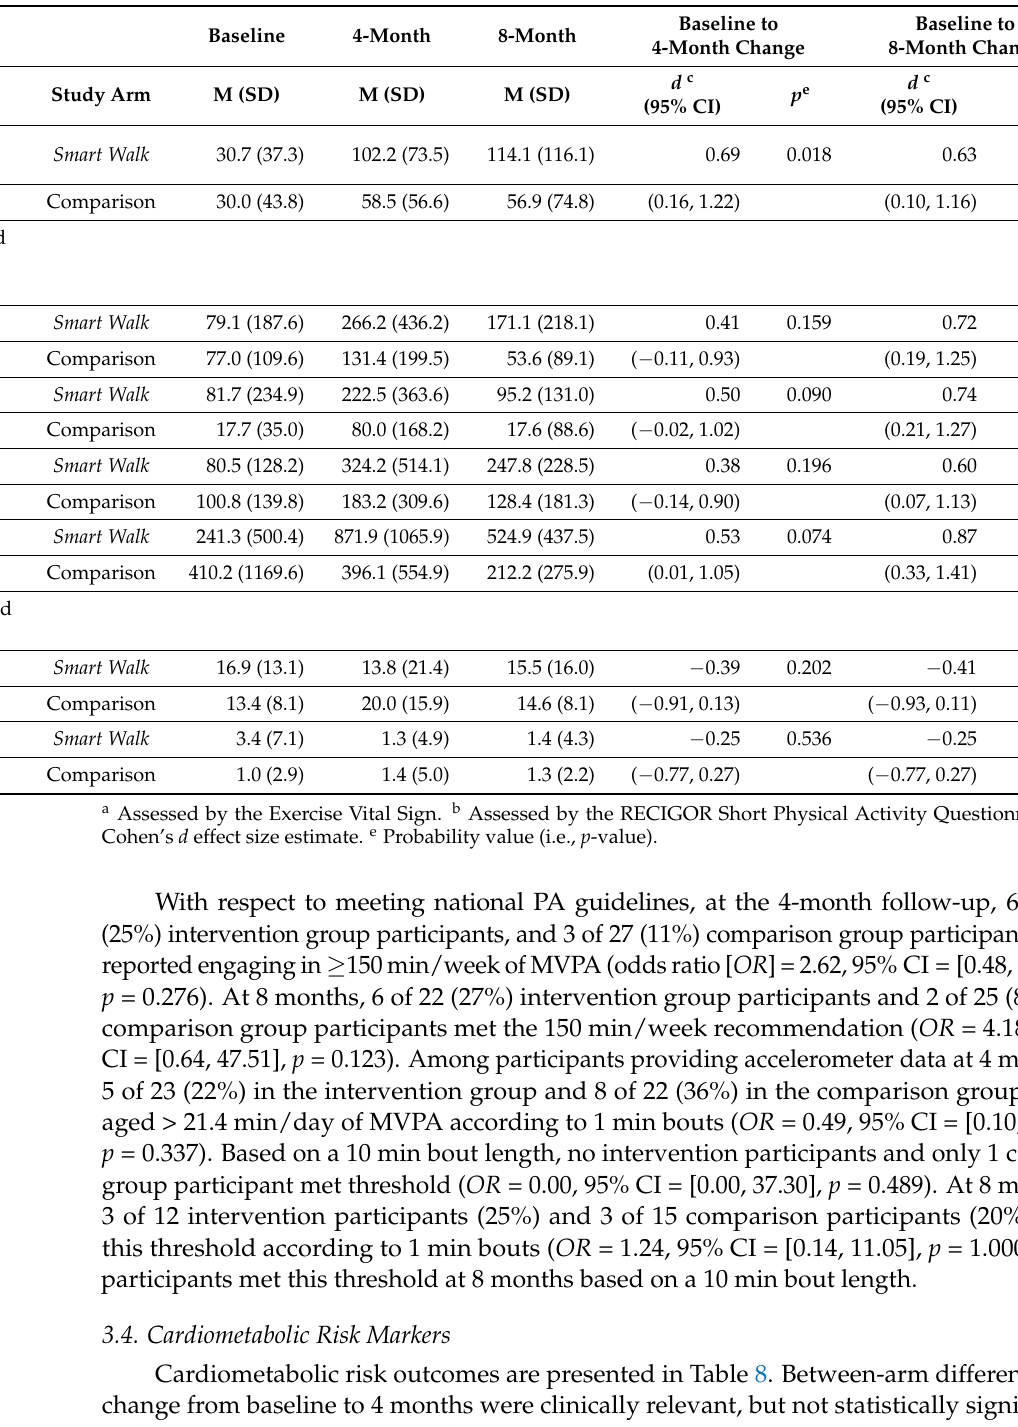
Table 7. Physical Activity